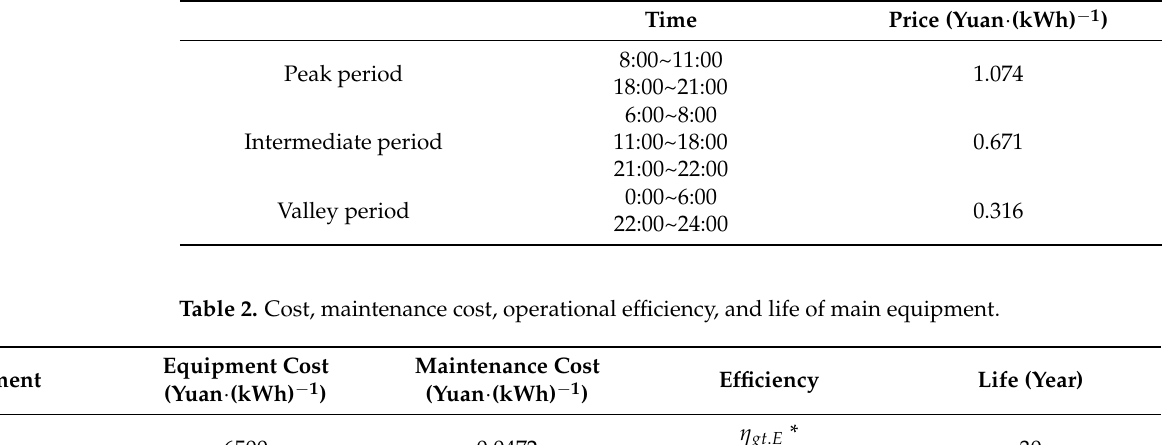
Table 1. Electricity prices in different periods.